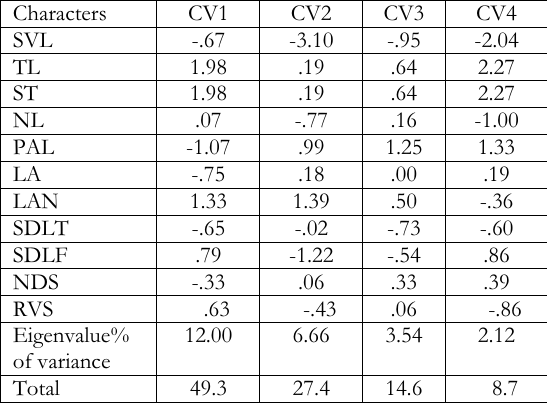
T ABLE 5. -Standardized coefficients for determining differences among all individuals of T. aurata transcaucasica and T. septemtaeniata . Eleven of thirty-one characters are statistically significant and meet selection criteria for the